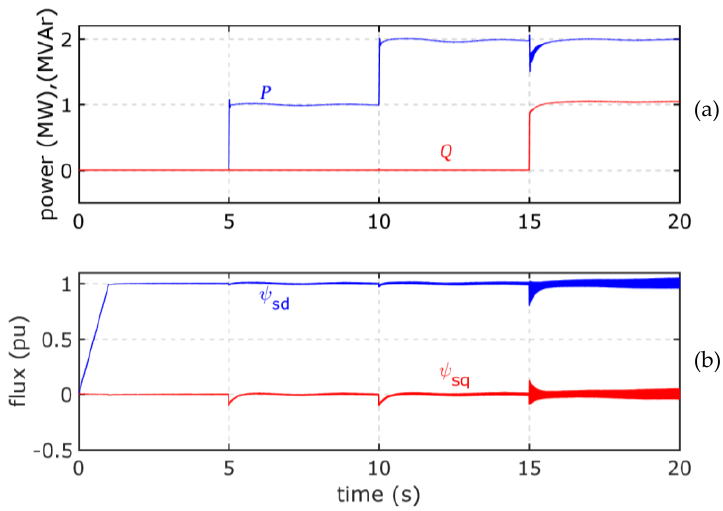
Figure 8. Operation at variable load and constant wind seep [( a ) load power; ( b ) stator flux].